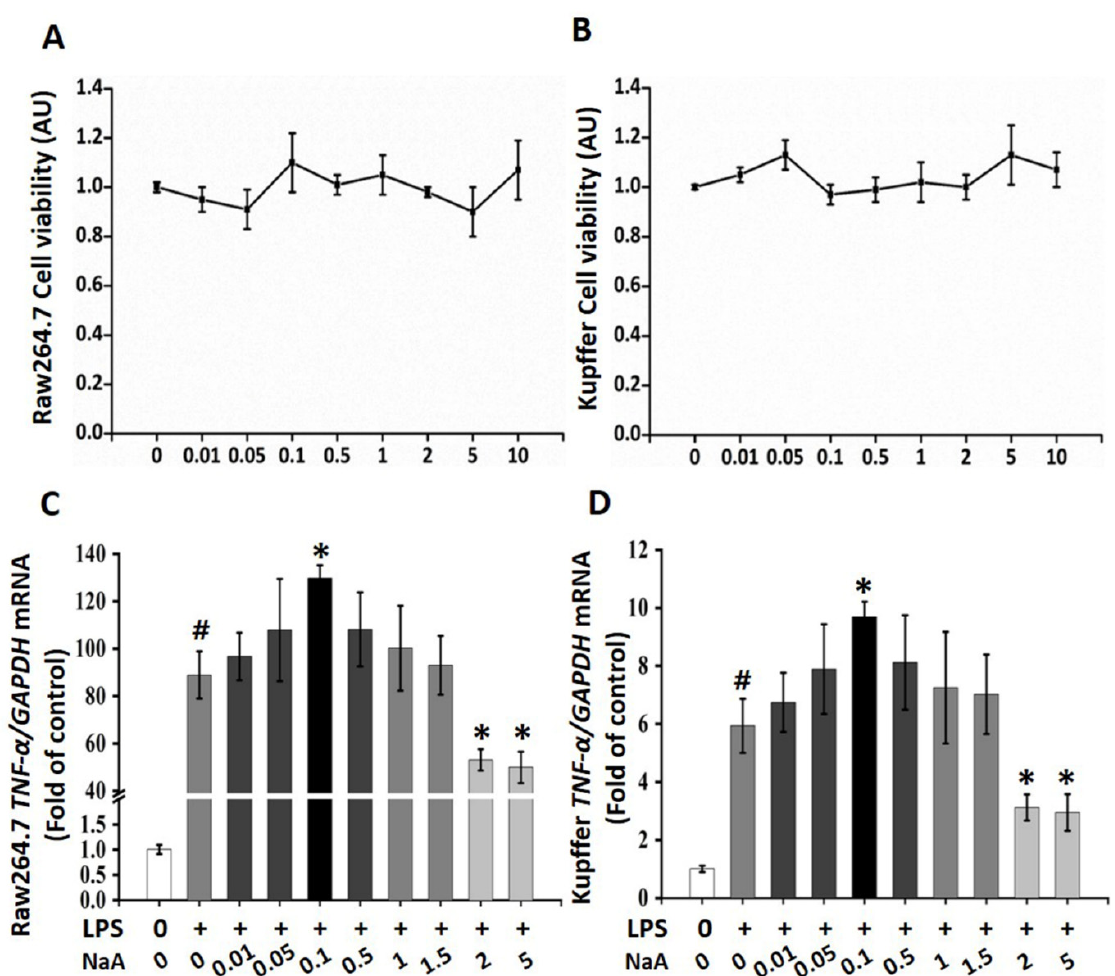
Figure 1. Effects of different doses of NaA on LPS-induced macrophage activation. NaA cytotoxic effects on RAW264.7 cells ( A ) or Kupffer cells ( B ). After serum starvation for 12 h, a CCK8 assay was performed for cells treated with 0~10 mM of NaA for 24 h. qRT-PCR was used to evaluate the mRNA expressions of TNF- α of RAW264.7 cells ( C ) or Kupffer cells ( D ). Cells were treated with or without 20 ng/mL LPS for 6 h following different doses of NaA for 24 h as detailed in the Materials and methods section. For all bar graphs, data are the mean ± SD, # p < 0.05, as compared with CON, and * p < 0.05, as compared with MOD. The significant difference was assessed using the one-way ANOVA followed by LSD post-tests. Control group (CON), group model cell treated with an LPS (MOD), arbitrary unit (AU).